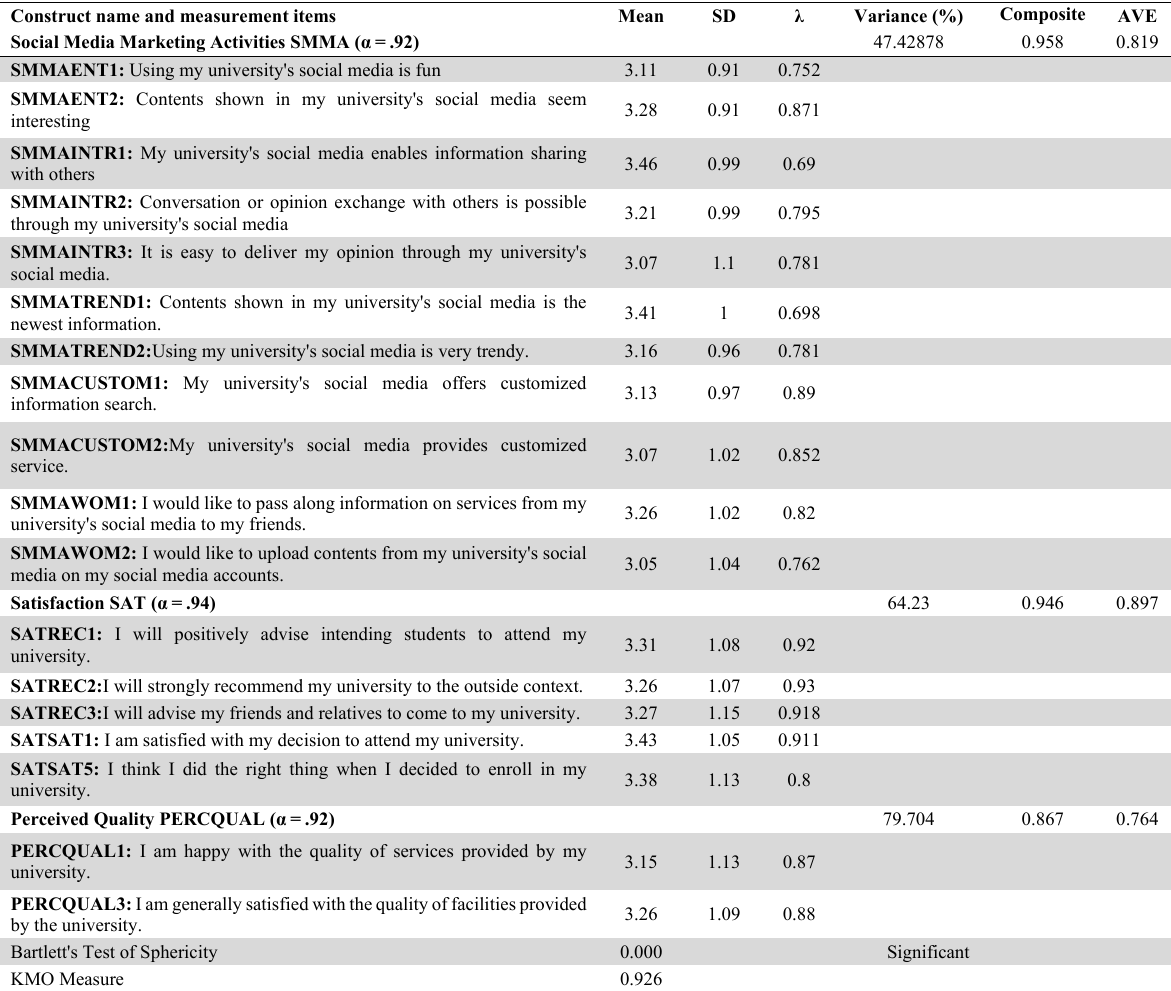
Measurement model estimation